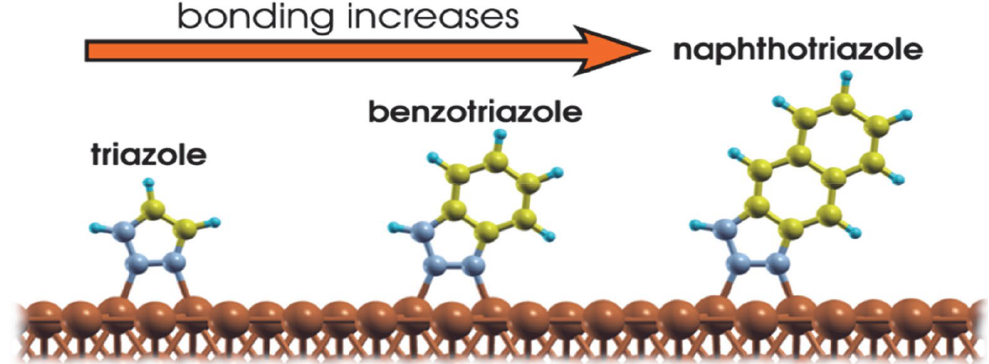
Figure 7. Optimized physisorption/chemisorption structures of triazole (TAH), benzotriazole (BTAH) and naphthotriazole (NTAH) on Cu surface. The bonding increases with molecular size from TAH to NTAH as calculated by density functional theory (DFT) calculations. ( Reprinted from